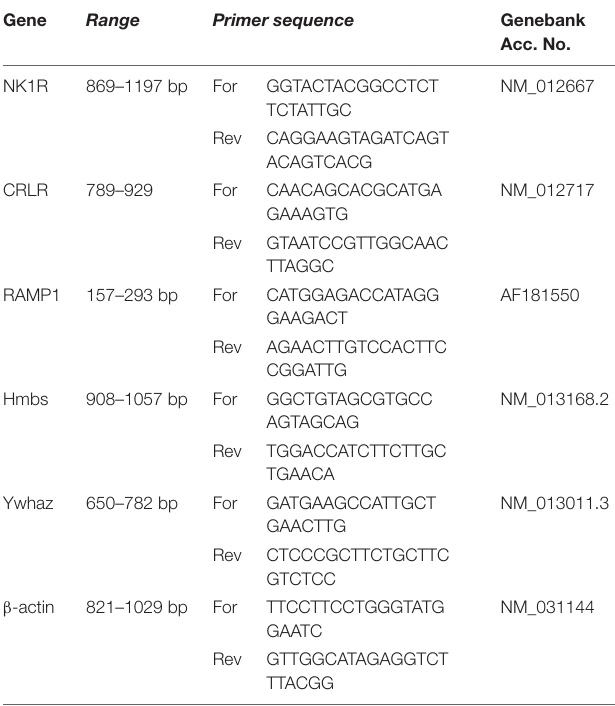
TABLE 1 | Characteristics of primer pairs used in RT-PCR. Gene Range Primer sequence Genebank